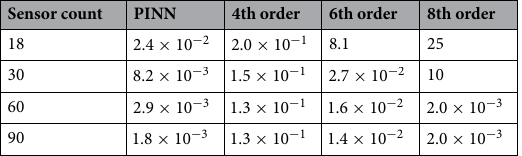
Table 3. Error measure in vector norm for the predicted and the other method’s different orders for various sensor counts.